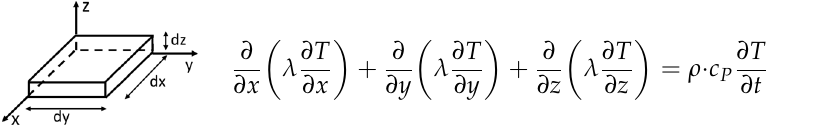
Figure 3. Main model definitions for the numerical study on the thermophysical properties of pol- ymer-based heat sinks ( a ). Schematic representation of the numerical case study ( b